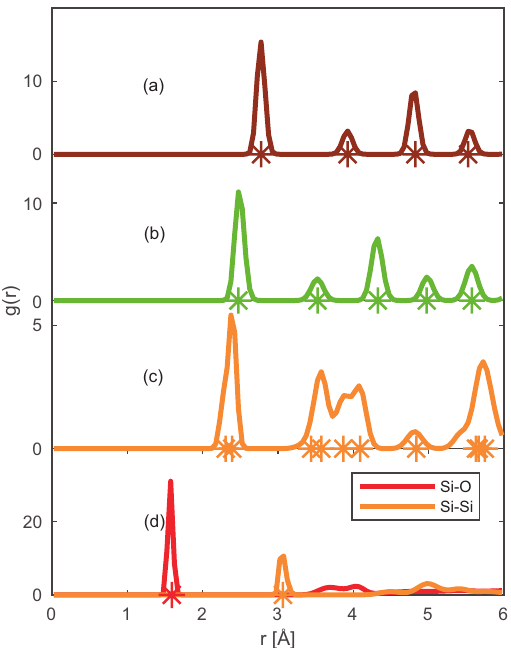
Figure 3. Radial distribution functions for: ( a ) Pt–Pt, ( b ) Ni–Ni, ( c ) Si–Si and ( d ) Si–O pairs present in studied solid crystals obtained from the ReaxFF MD simulations. The ‘ ∗ ’ represents the neighboring atomic distances inside the solid crystal. For clarity, only the nearest neighbor ‘ ∗ ’ is shown in SiO 2 . The sharp peaks in RDF elucidate the extent of ordering in the supercell, thus representing the solid phase. The locations of the peaks coincide with the position of neighboring atoms (represented by ‘ ∗ ’) in the experimentally observed solid crystal [36–39]. Concluding that the selected force fields [4,19] can capture the crystalline phase of Pt, Ni, Si, and SiO 2 .